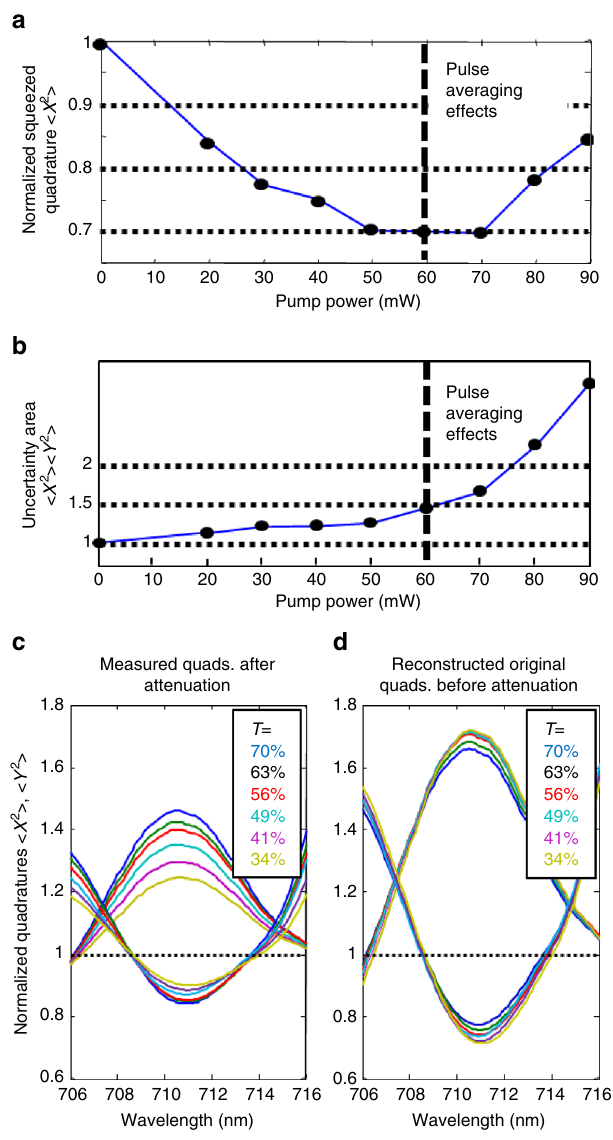
Fig. 8 Expanded homodyne results. a Measured squeezed quadrature as a function of squeezing strength (696 nm) — (solid line for guidance only). As the squeezing strength in the fi rst pass is increased, the measured (cid:1) (cid:3) (cid:7) 0 : 68 at a pump power of squeezed quadrature decreases, down to x y x ~ 60 mW. Further increase of the pump degrades the observed squeezing due to temporal effects of the pulsed pump. b Minimum uncertainty conservation (696 nm) — (solid line for guidance only). Ideal squeezed (cid:1) (cid:3) (cid:1) (cid:3) y y y ¼ 1, independently of vacuum is a minimum uncertainty state of x y x the squeezing strength. Up to a pump power of 60 mW, the uncertainty (cid:1) (cid:3) (cid:1) (cid:3) y y y < 1 : 3). Beyond this limit the area is indeed nearly conserved ( x y x The effect of loss on the squeezed state. c We apply a series of loss values (30 – 66%) to a given squeezed state and observe the in fl uence on the squeezed/stretched quadratures. d The reconstructed “ bare ” squeezed/ stretched quadratures that calibrated out the loss from all the curves of c , demonstrating collapse of all the curves to nearly the same value,